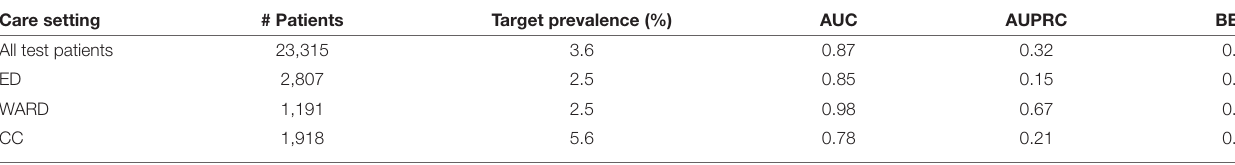
TABLE 8 | Model performance on all test patients as well as patients belonging to different care settings at 2 h before the intervention onset. Care setting